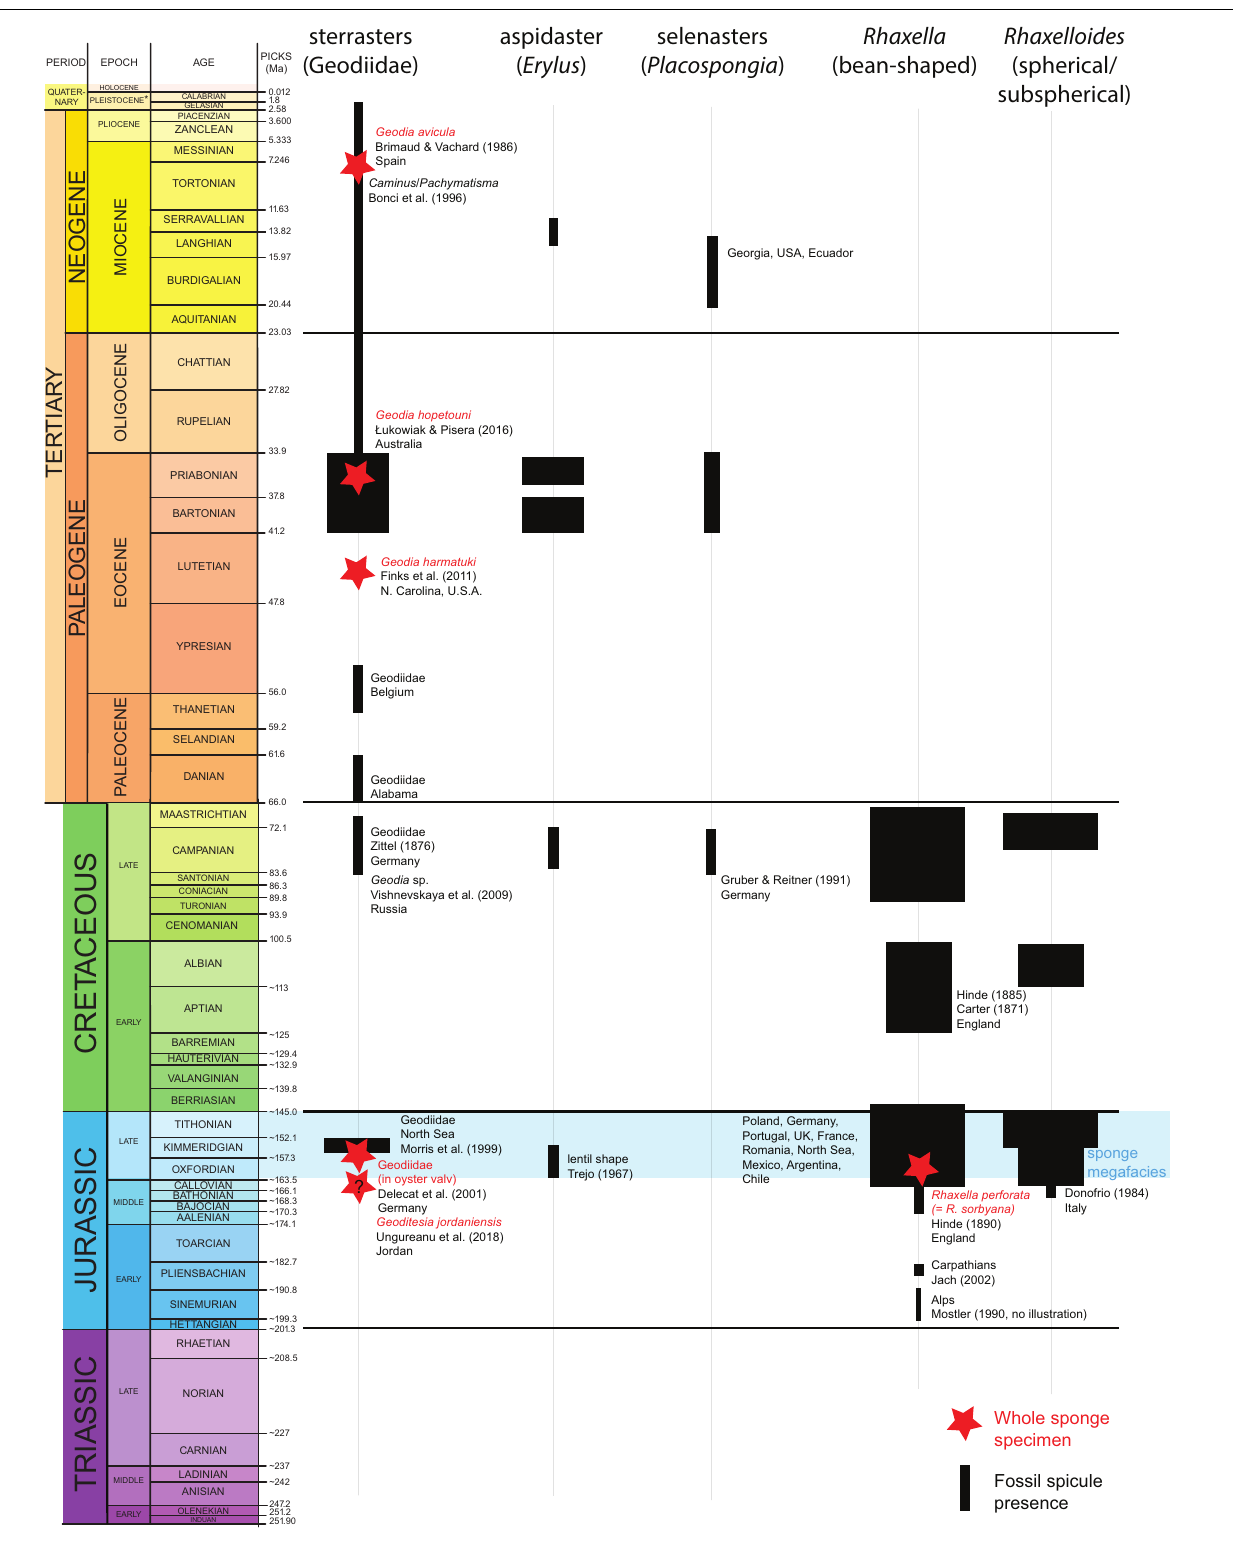
FIGURE 10 | Timeframe of ball-shaped fossil spicules from the Trias to the Holocene. Red stars represent whole body fossils. Black lines represent presence of the respective fossils (sterraster, aspidaster, selenaster, rhax, or smooth sphere); the width of the black lines is indicative of the abundance of these fossils. For literature references used to build this timeframe, see Supplementary Table S1